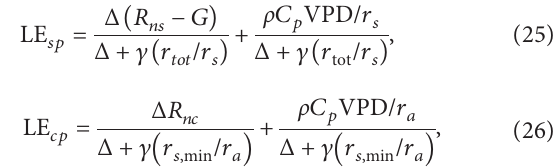
Figure 10: T − T c variables with T r a under different f c conditions in Lhomme empirical